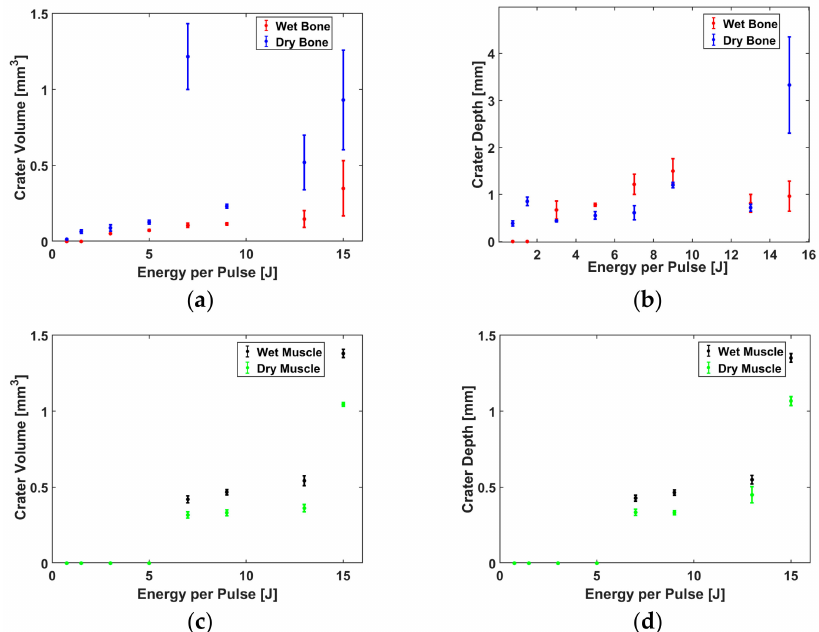
Figure 5. Bone and muscle comparison of the average ablation e ffi ciency for five dry and wet craters as a function of energy with 10 pulses: ( a ) bone crater volume and ( b ) depth ablations; ( c ) muscle crater volume and ( d ) depth